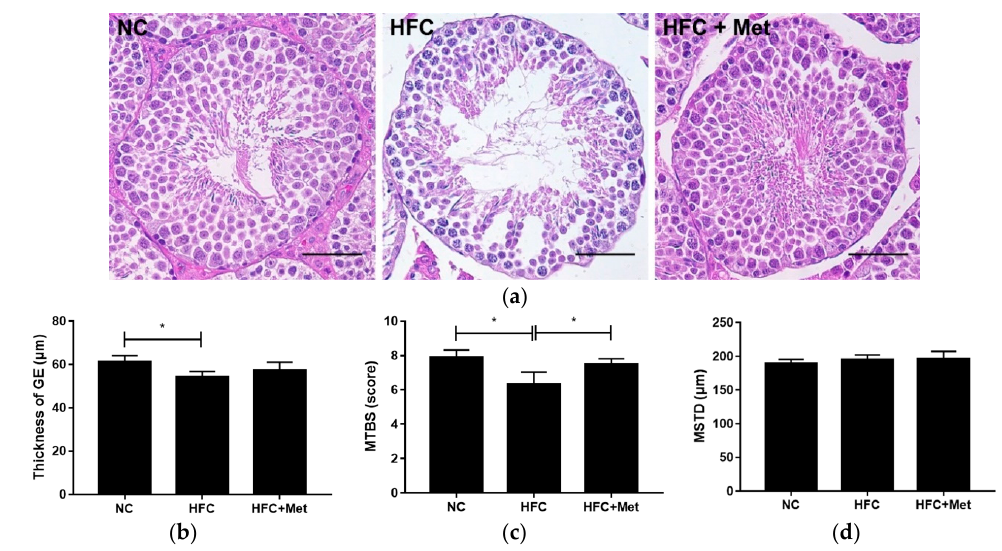
Figure 4. Effects of the high-fat and high-cholesterol diet and metformin supplementation on ( a ) testicular histology, ( b ) thickness of the germinal epithelium (GE), ( c ) mean testicular biopsy score (MTBS) and ( d ) mean seminiferous tubule diameter (MSTD) in the male mice: Testicular sections were stained with hematoxylin and eosin. Data are expressed as means ± SD ( n = 5 per group). * p < 0.05 as determined by one-way ANOVA followed by LSD post hoc test. NC, normal diet; HFC, high-fat and high-cholesterol diet; HFC + Met, HFC with metformin supplementation. Scale bar: 50 μ m.